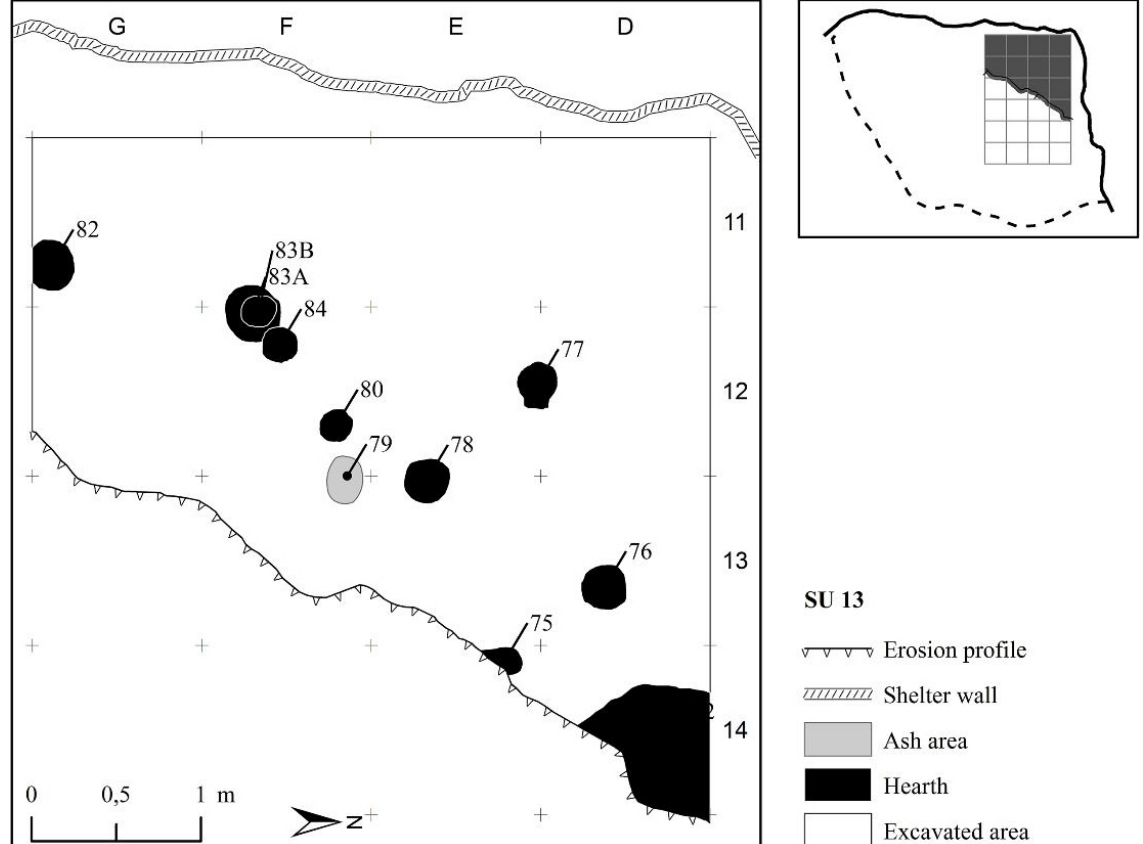
Figure 4. SU 13 planimetry (Relief made by Boscato, draw by